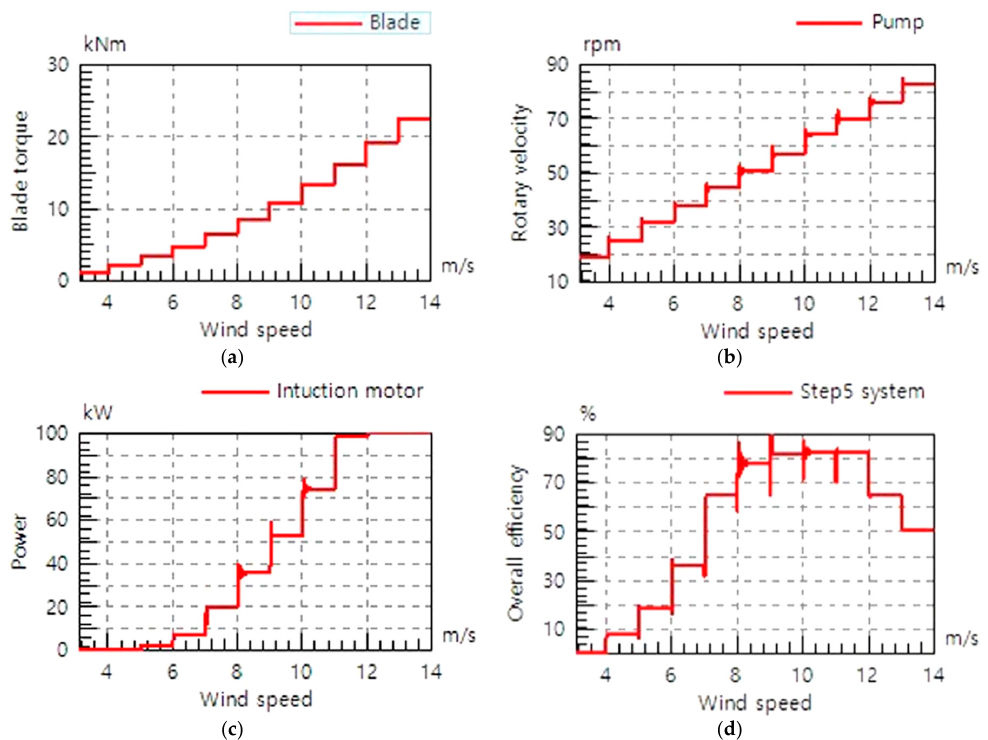
Figure 9. Basic characteristics analysis results of step 5. ( a ) Turbine blade torque; ( b ) hydraulic pump; ( c ) induction motor power; and ( d ) step 5 overall efficiency.